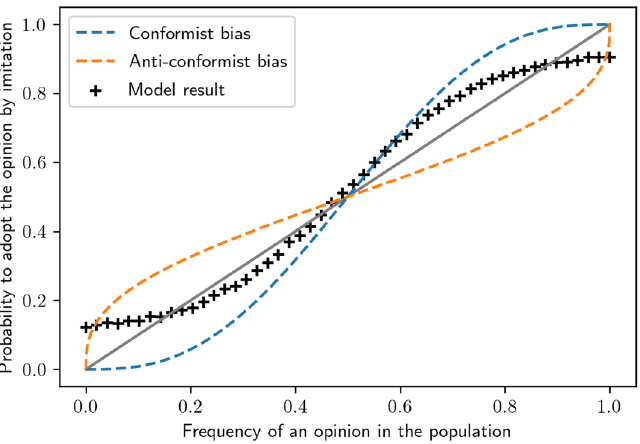
Figure 1. Definition of a (anti-) conformist bias (dashed orange and blue lines) in the cultural evolution literature 6,7 , compared with the outcome of our model (explained in Sect. 2.5) where some endogenous heterogeneities are